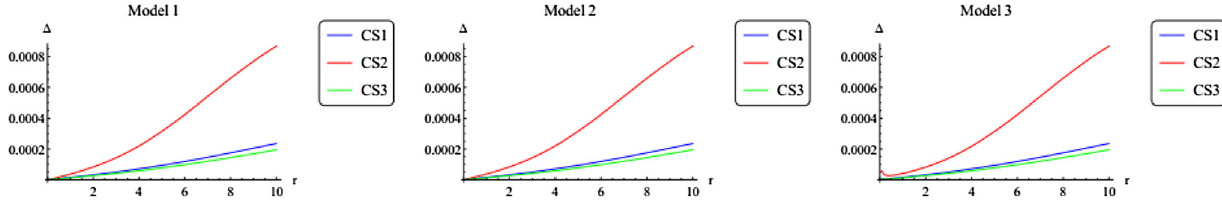
Fig. 18 Variations of anisotropic measure (cid:18) with respect to the radial